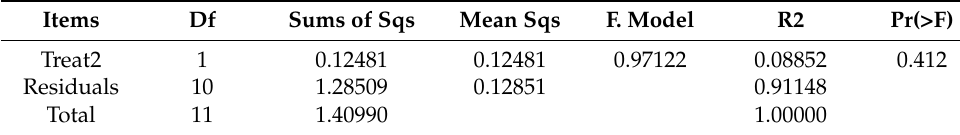
Figure 2. PCoA clustering circle plot in fecal microbiota of captive giant pandas adopting different nursing methods. Note: In the figure, each point represents a sample, and the points with different colors belong to different samples (groups). The closer the distance between the two points, the smaller the difference in the species composition of the two samples and the higher the similarity. The percentages in brackets on the axes represent the proportion of the variance in the raw data that can be explained by the corresponding principal coordinates. Table 3. Species composition Adonis difference analysis results between groups.